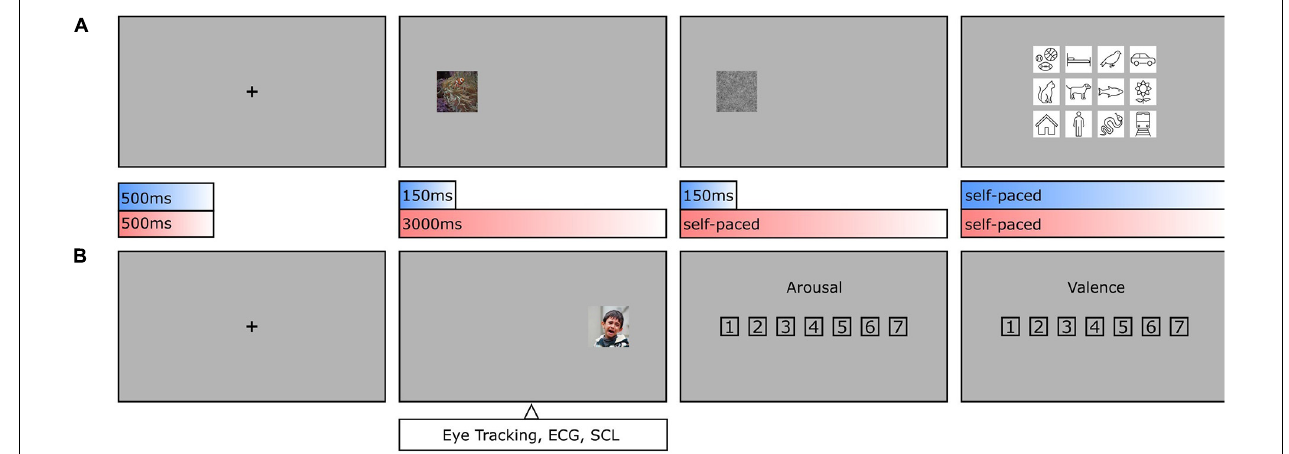
FIGURE 2 | Object recognition paradigm. (A) During categorization trials, human observers had to focus on a fixation cross (500 ms, including a 150 ms fixation control) before an image was presented on either the left or the right side (150 ms), followed by a visual backward mask (150 ms, 1/f noise), and a forced-choice categorization (self-paced, max. 7,500 ms). (B) During rating trials and after the fixation cross, an image was presented again on the left or the right side (3,000 ms), followed by an arousal rating and valence rating (both self-paced, max. 7,500 ms each). As conditions were pseudo-randomized, human observers were not able to anticipate, whether an image needed to be categorized or rated until the initial 150 ms had elapsed. This allows the assumption that in the first 150 ms the conditions should not vary in viewing